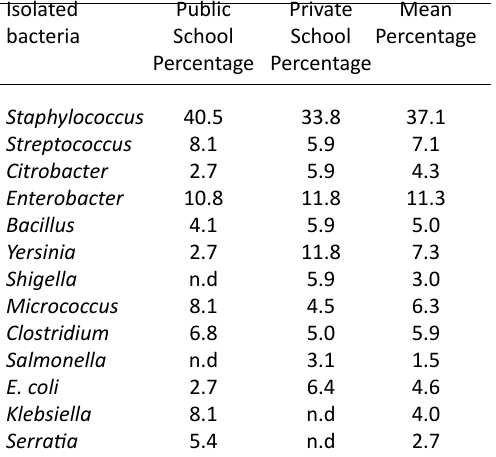
table 2. Pattern and features of bacterial contamination in the two schools